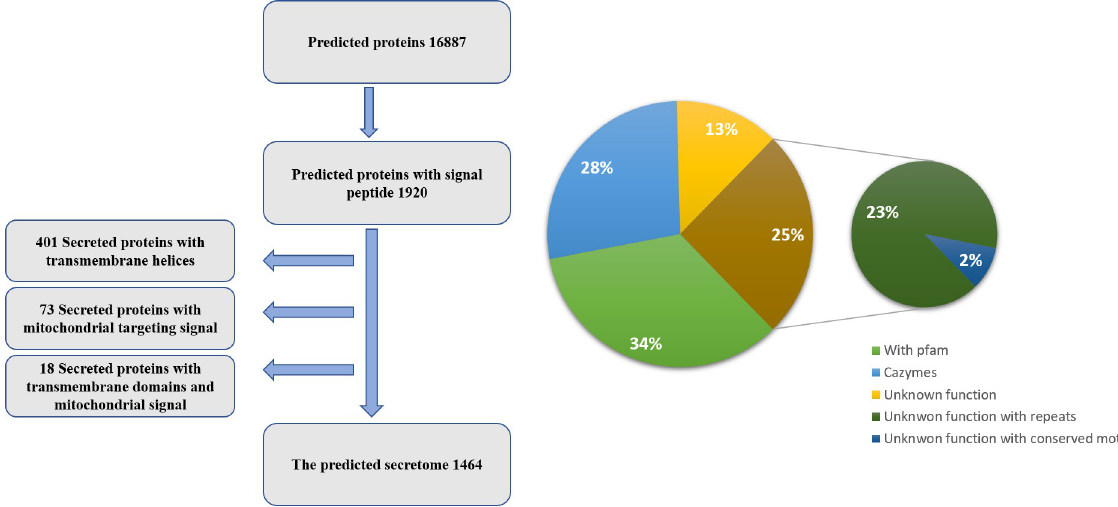
Fig 2. F . oxysporum f. sp. albedinis genome code for a large repertoire of secreted proteins. A. Overview of the computational pipeline used to mine predicted secreted proteins. B. Pie chart showing percentages of the main protein groups in the secretome.